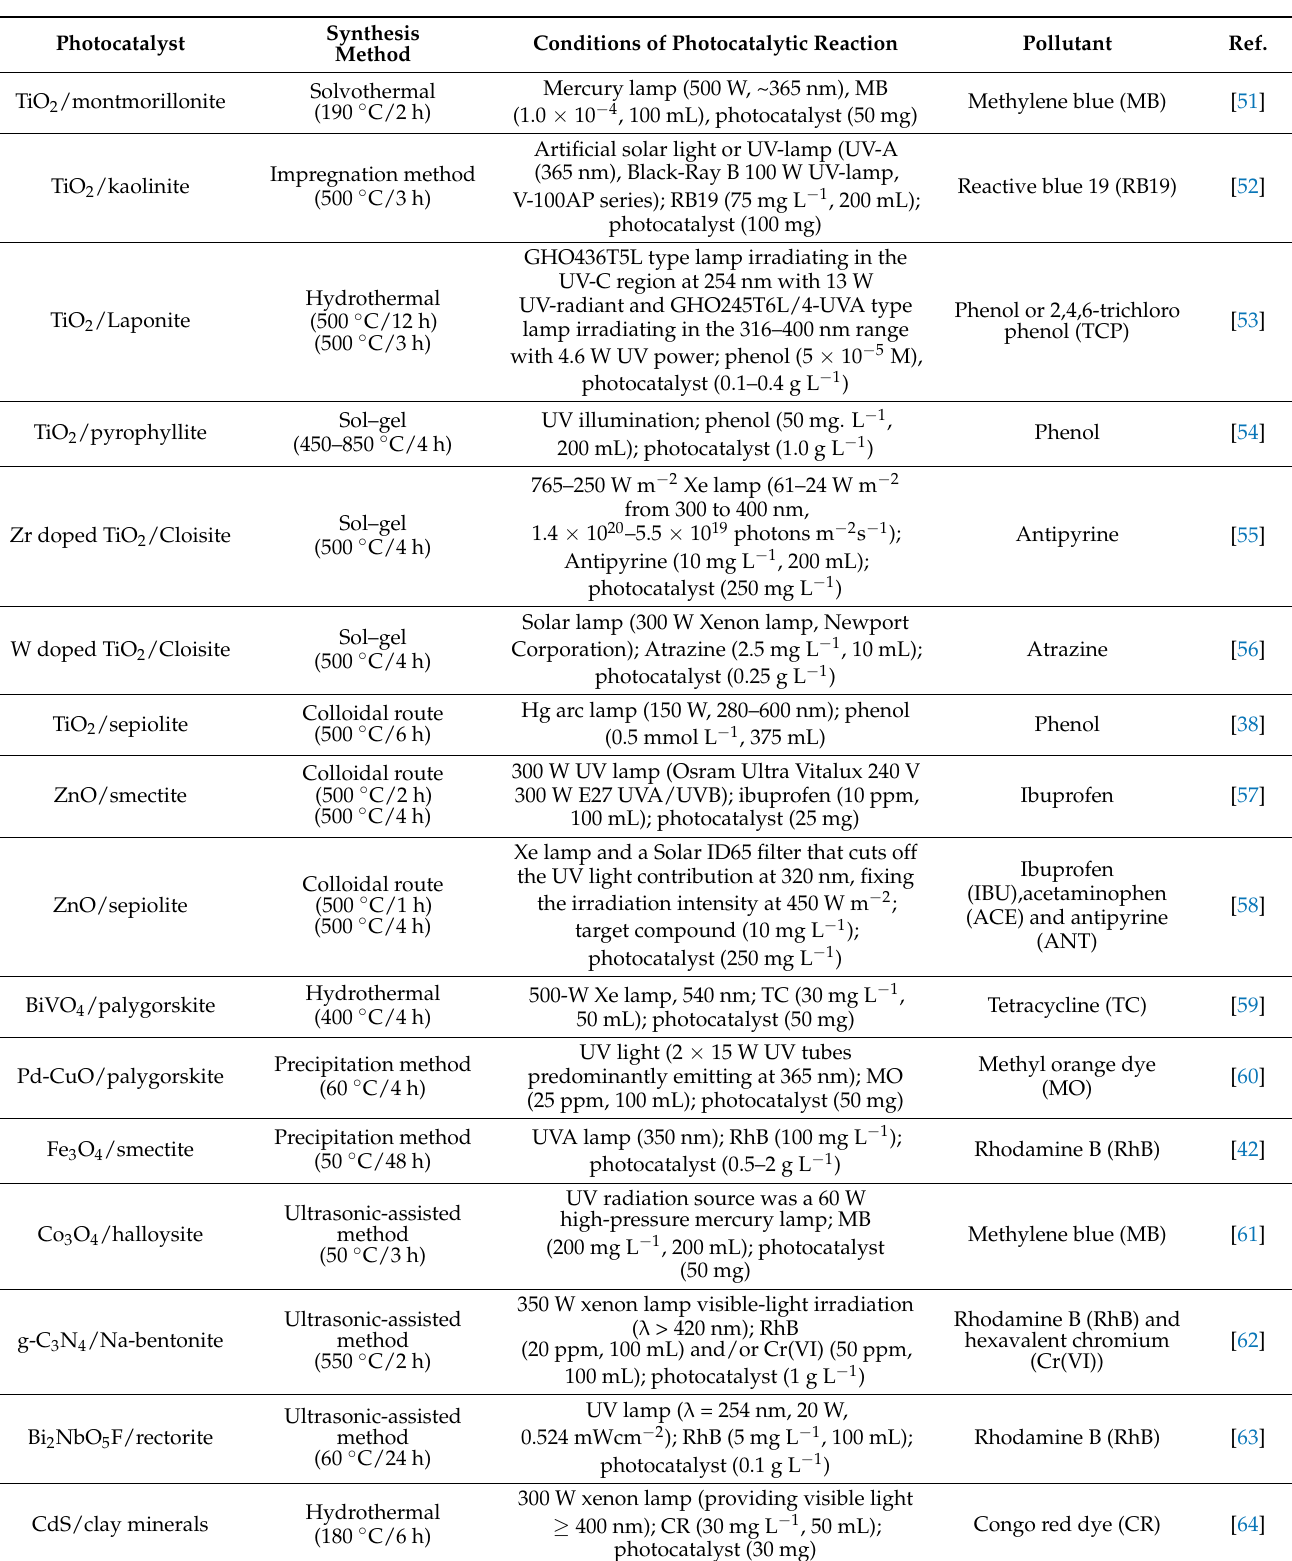
Table 1. Synthesis methods, reaction parameters, and application of the different